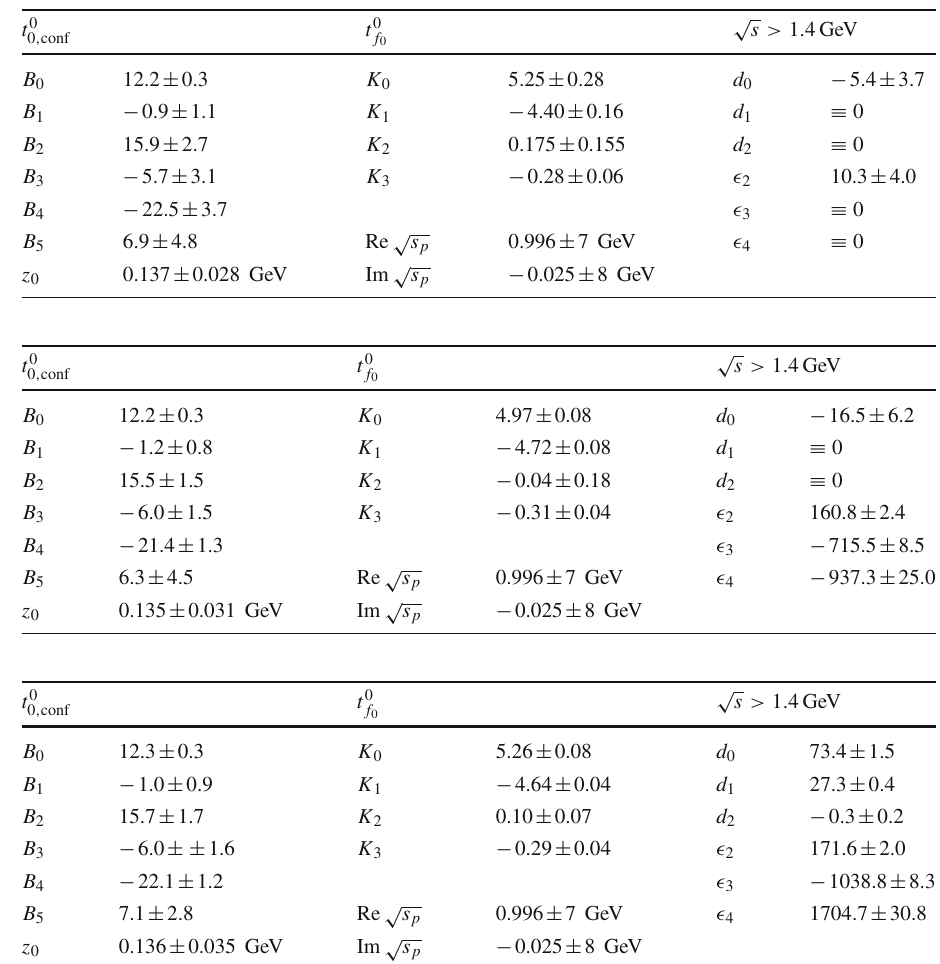
Table 3 Fit parameters of the global parameterization for the S 0-wave solution III. s p is the f 0 ( 980 ) pole position from the dispersive analysis in [36]